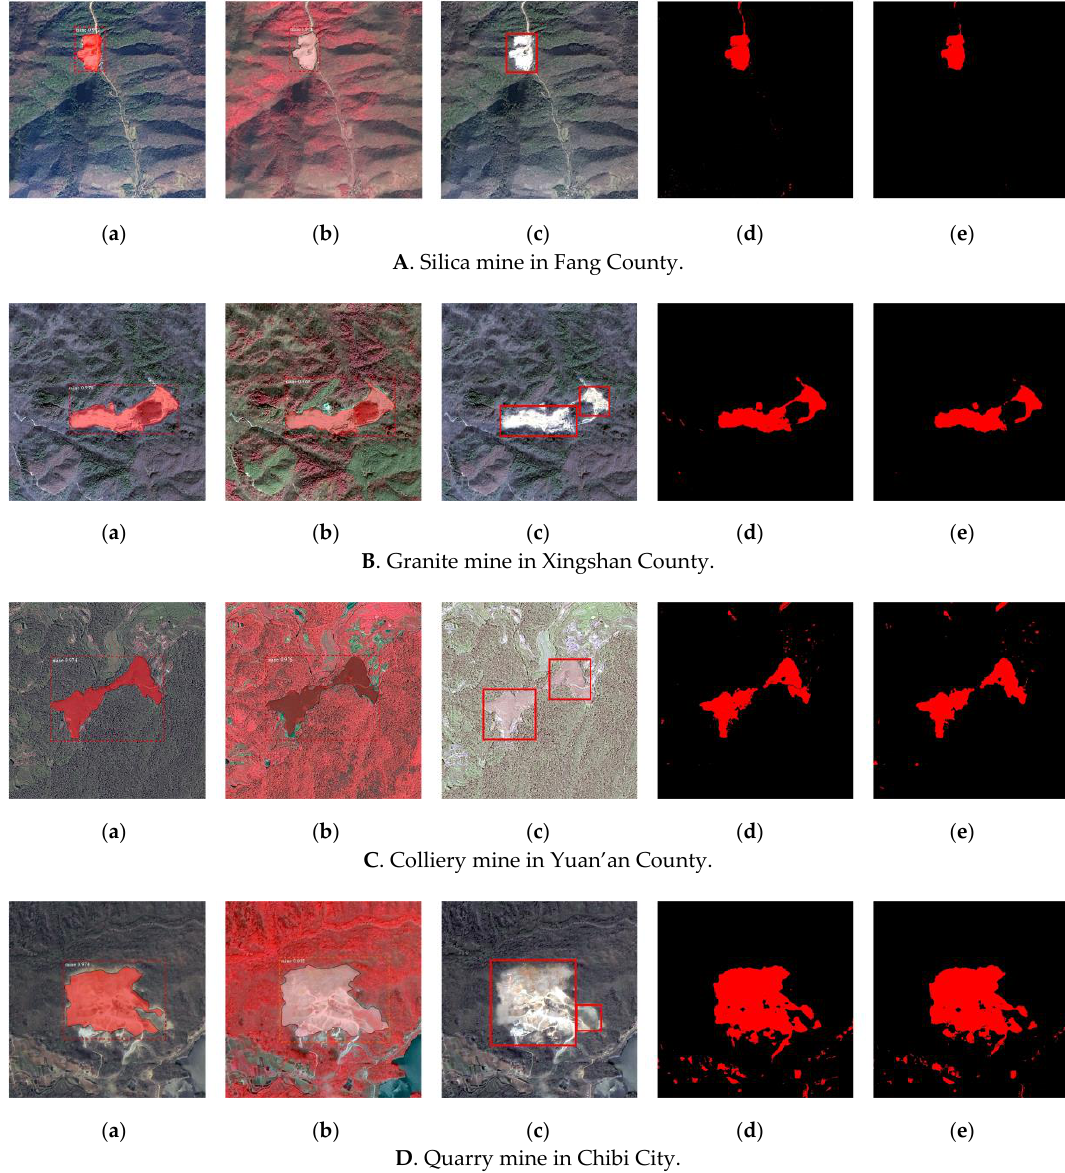
Figure 10. Mine identification results. ( a ) Improved Mask R-CNN and Transfer learning (IMRT) identification results of the true-color image; ( b ) IMRT identification results of the false-color image; ( c ) faster R-CNN identification results; ( d ) Maximum Likelihood (MLE) identification results; ( e ) Support Vector Machine (SVM) identification results. Table 1. Precision evaluation based on pixels.